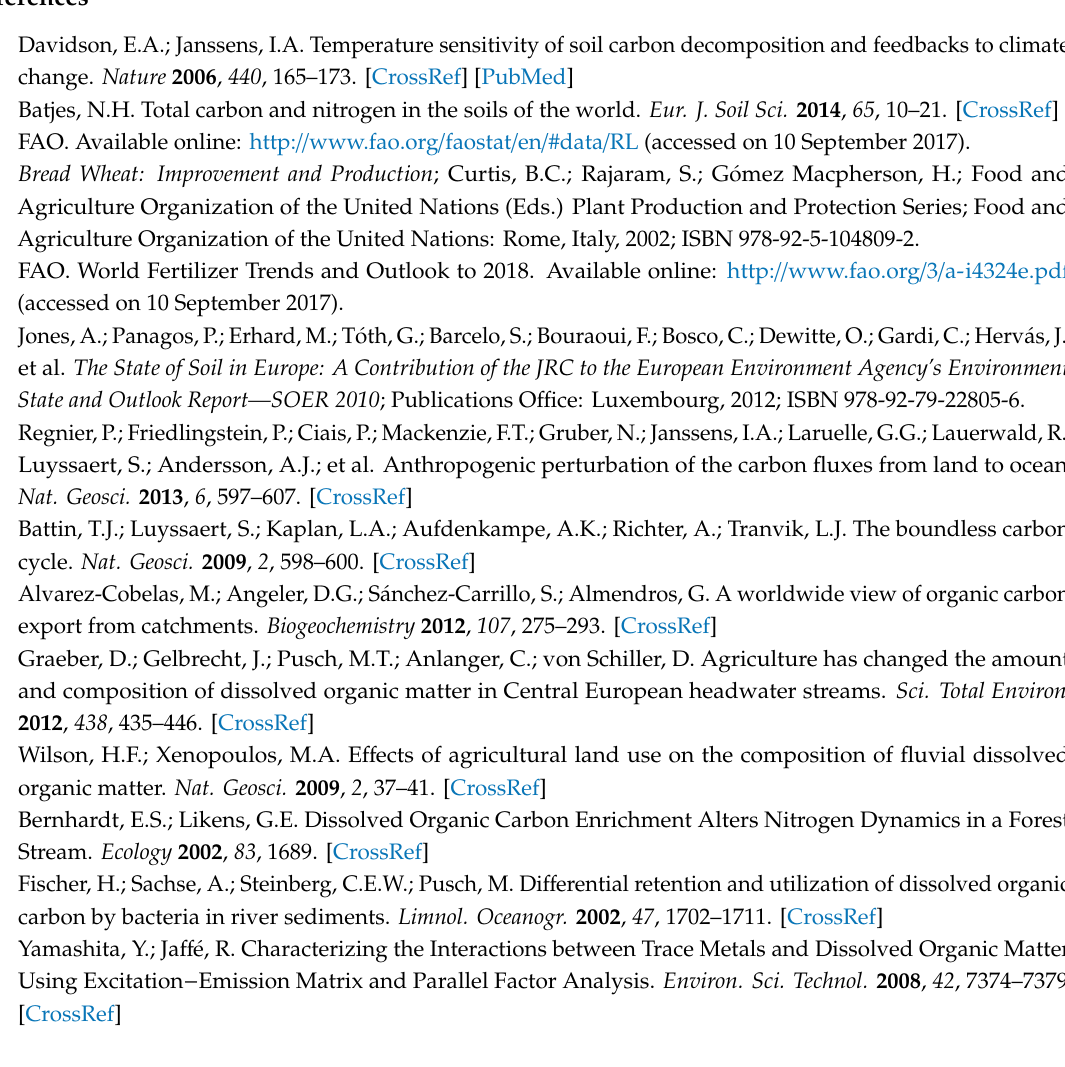
Figure S1: Schematic illustration of a lysimeter subunit, Table S1: Basic soil properties of the soil cores for the lysimeter